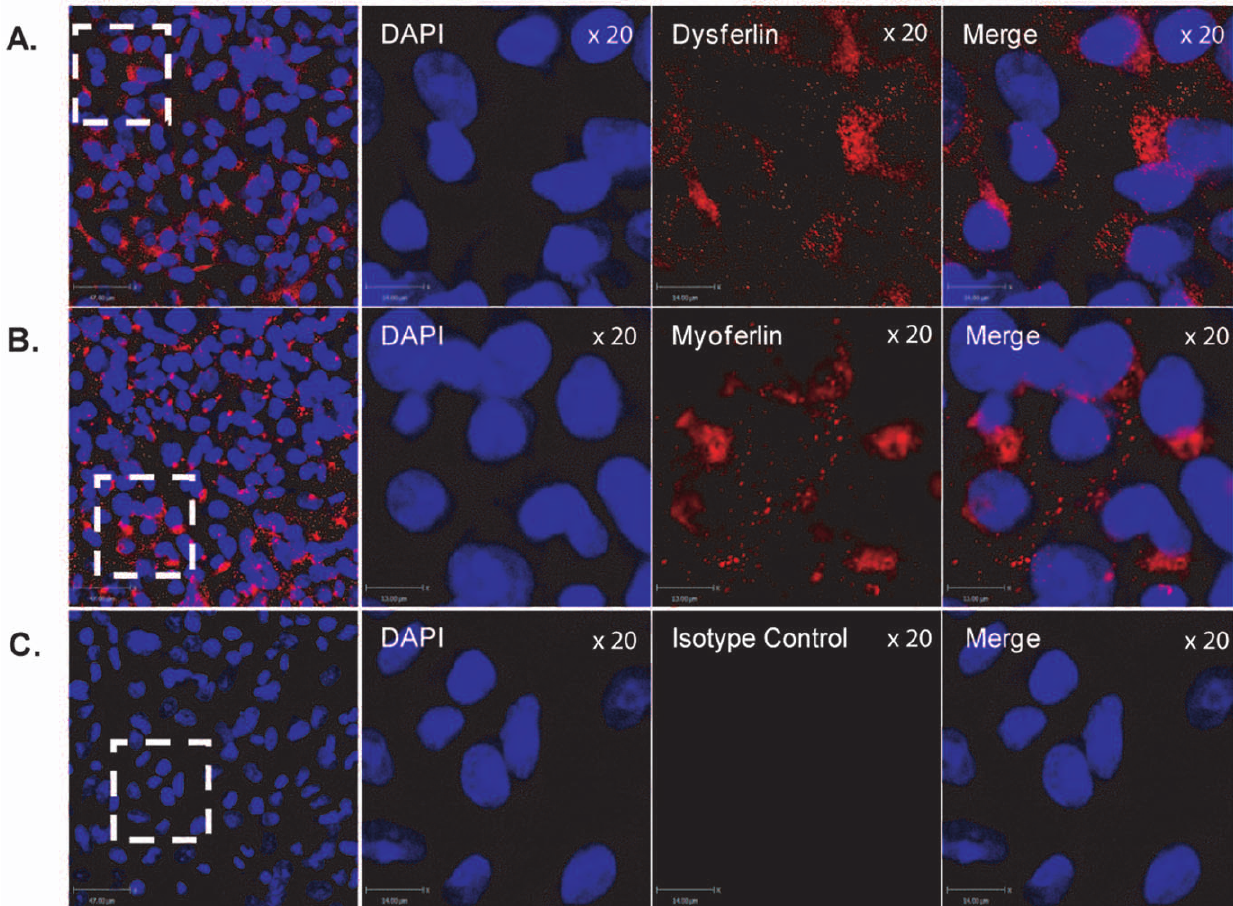
Figure 3. Localization of dysferlin and myoferlin in airway epithelial cells. 16HBE cells were grown to confluency on 8 well chamber slides and fixed for immunofluorescence analysis. Immunofluorescent staining for (A) dysferlin ( red ), (B) myoferlin ( red ), (C) mouse immunoglobulin isotype, and nuclei stained with 4 9 ,6-diamidino-2-phenylindole ( blue ), were used to examine the localization of dysferlin and myoferlin. Scale bars are equal to 47 m m, and 14 m m on the digital zoomed